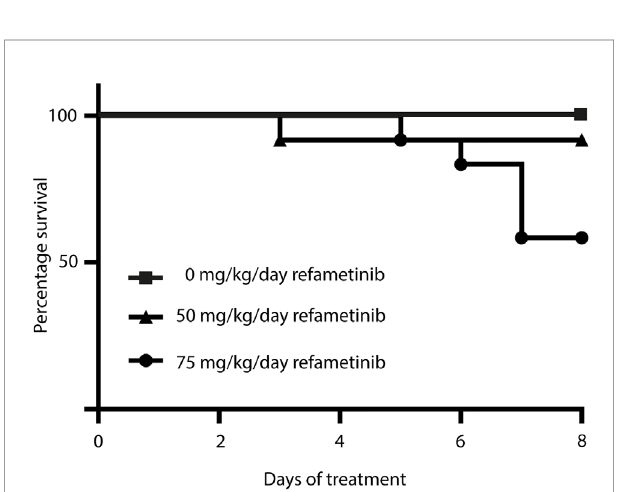
FIGURE 3 | Refametinib plasma levels. Presence of refametinib was observed in the plasma of mice after administration of 50 or 75 mg/kg/day refametinib supplemented drinking water for 7 days. No signi fi cant difference in refametinib plasma levels was observed between the different dosage groups (independent two-sample t-test, p = 0.085). Red line at 1.2 µg/mL represents active refametinib serum concentrations previously observed by Iverson et al. (2009).